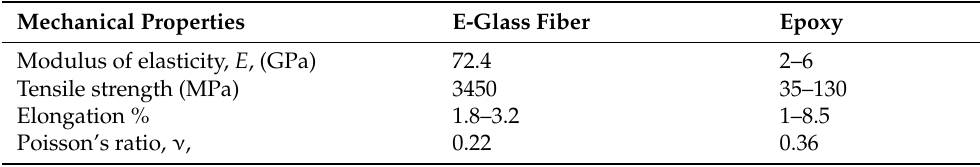
Table 1. Mechanical properties of E-glass fiber and epoxy resin. Mechanical